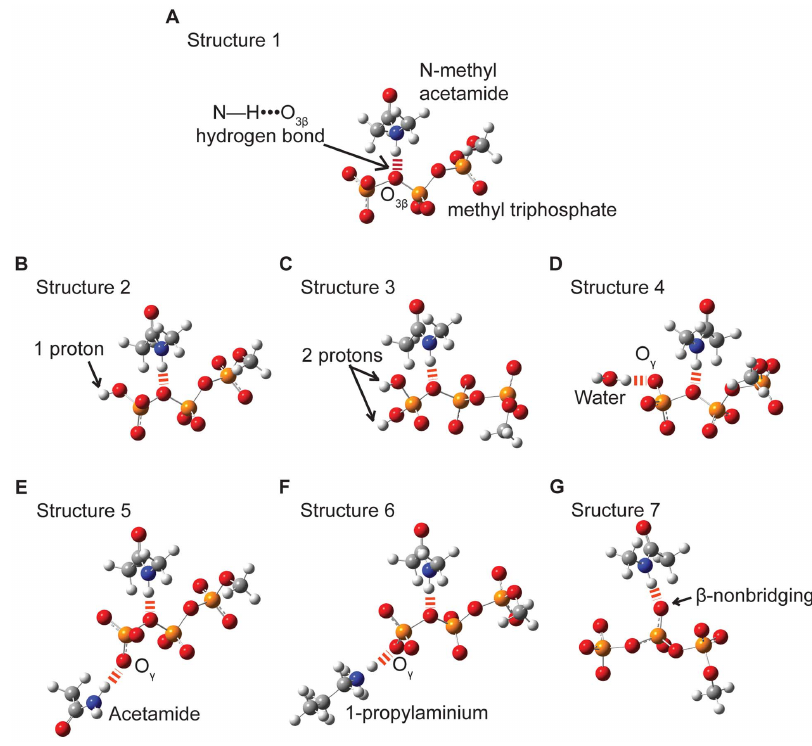
Figure 2. Models used to test the dependence of hyperconjugation and O 3 b _P c bond length on enzyme-ligand interactions. N- methylacetamide (A) was used to model a (neutral) protein backbone amide hydrogen bond to O 3 b , using methyl triphosphate to model an NTP nucleotide. Structures 2 (B) and 3 (C) were used to investigate the effects of protonation at the c -oxygens. Additional active site hydrogen bonds, represented in Structures 4 through 6 (D–F), were used to assess the secondary effects of different types of O c hydrogen bonds. Acetamide (E) 1- propylaminium (F) were used to model asparagine and lysine side chains respectively. Structure 7 (G) was used to investigate the impact of hydrogen bonding at a nonbridging b -oxygen on hyperconjugation and O 3 b _P c bond length. Hydrogen bonds are shown with dashed red lines. White=hydrogen, gray=carbon, red=oxygen, blue=nitrogen, orange=phosphorus.